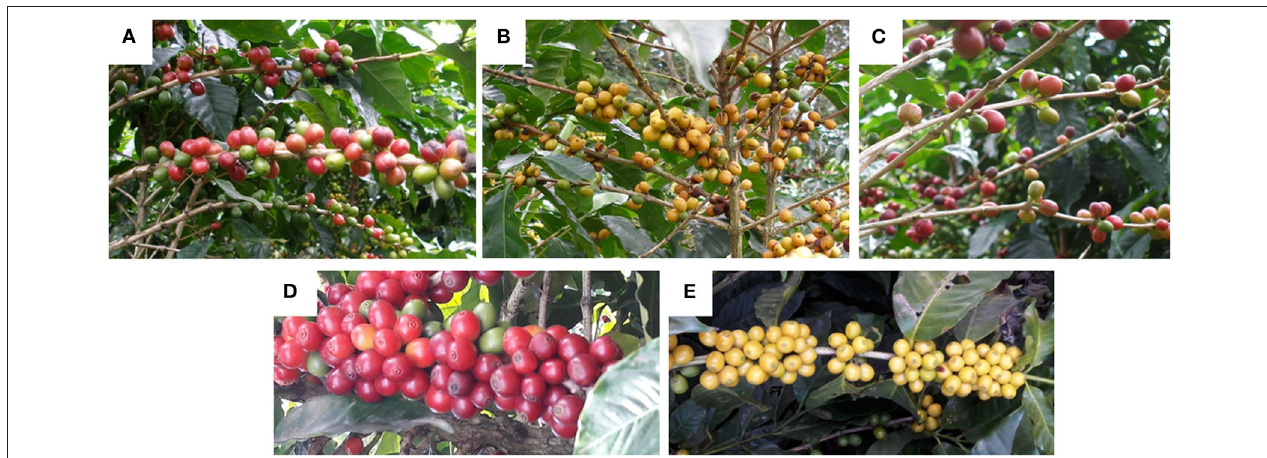
FIGURE 4 | Photographs of the ripe coffee berries analyzed in this work: (A) Caturra Rojo (red), (B) Anaranjado (orange), (C) Catuaí Rojo (red), (D) Arábica (red), (E) Caturra amarillo (yellow).